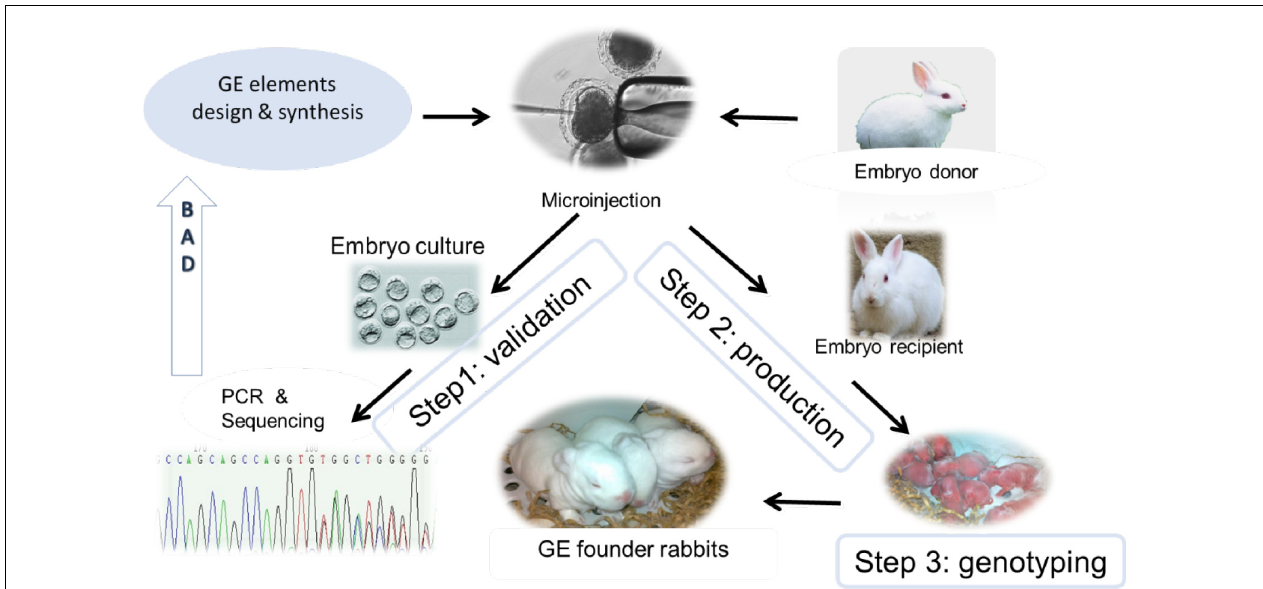
FIGURE 1 | Illustration of GE rabbit production. After GE element design and synthesis, they will be subjected to in vitro validation (Step 1) using embryos harvested from embryo donor animals. In the event of Step 1 failure (“BAD” arrow), GE elements will be re-designed and validated. After passing Step 1 validation, GE elements